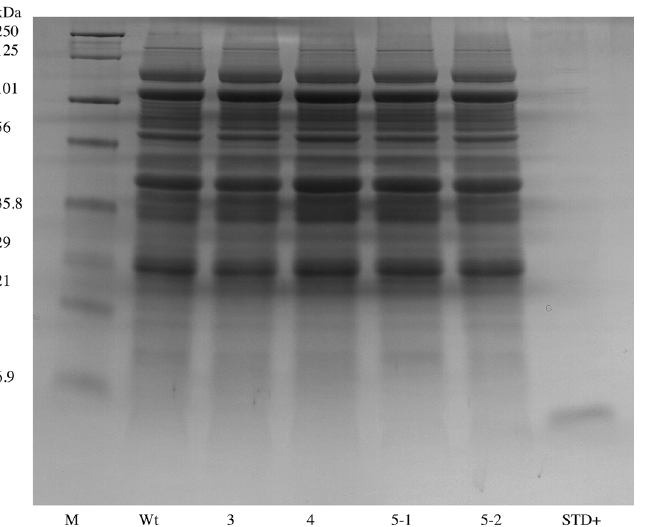
Fig 2. Analysis of total soluble protein by one-dimensional gel electrophoresis of hEGF expressing transgenic soybean seeds. Proteins from 3 independent homozygous EGF transgenic soybean lines (3, 4, 5) were extracted and compared to seed extracts from nontransgenic (Wt) and commercially available hEGF standard (STD+). M marker, kDa kilobases.